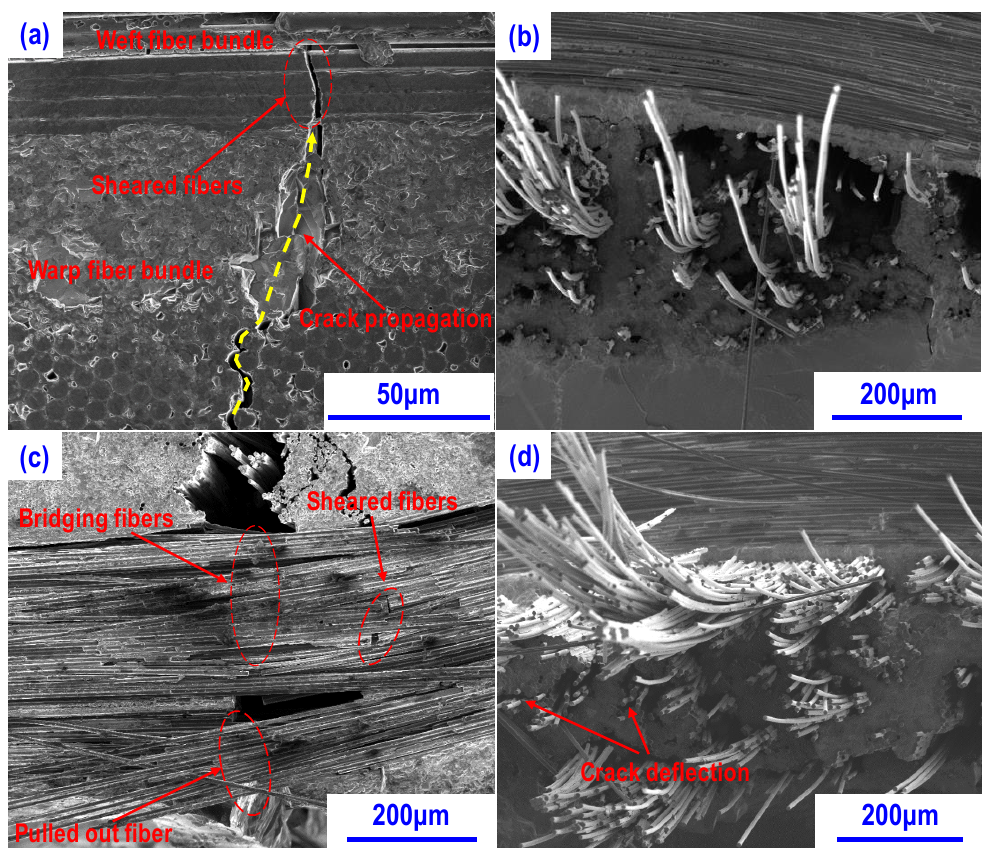
Figure 7. Morphologies of composites after flexural test at RT: ( a ) the side view of failed CSZ0 showing the sheared fibers by crack after passing through the matrix; ( b ) fracture surface of CSZ0; ( c ) the side view of failed CSZ10 showing the occurrence of interface debonding induced by crack propagation; ( d ) fracture surface of CZS10.